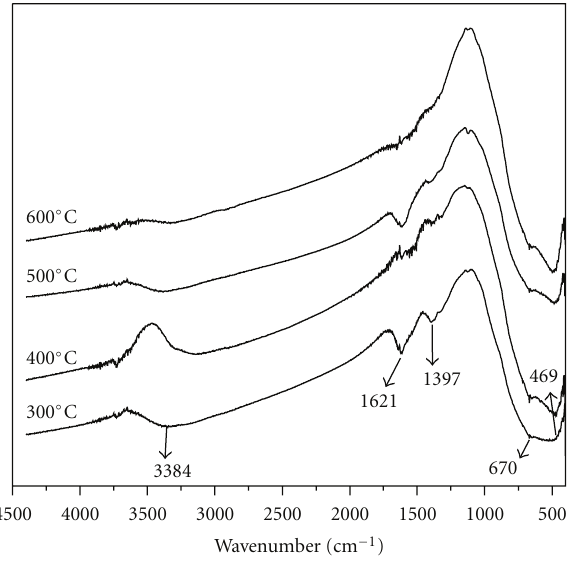
Figure 3: FT-IR spectra of 3% B-TiO 2 samples with di ff erent calcination temperature.